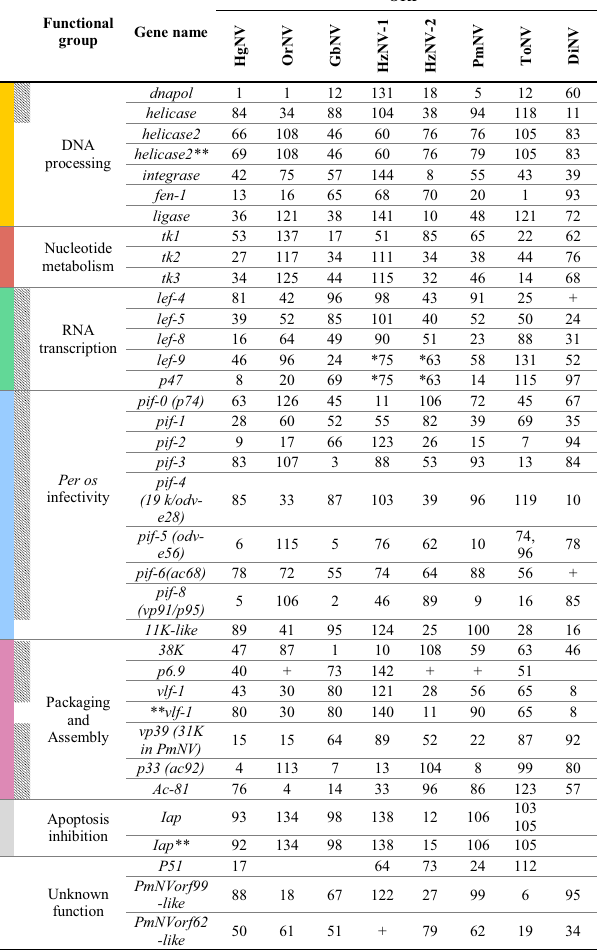
Figure 4. HgNV homologs to conserved nudivirus sequences. Colours as in Fig. 3. * Fused to a single gene. ** Multiple copy number. Shaded cells of second column indicate ‘core nudivirus genes’ shared with the Baculoviridae . + Reported